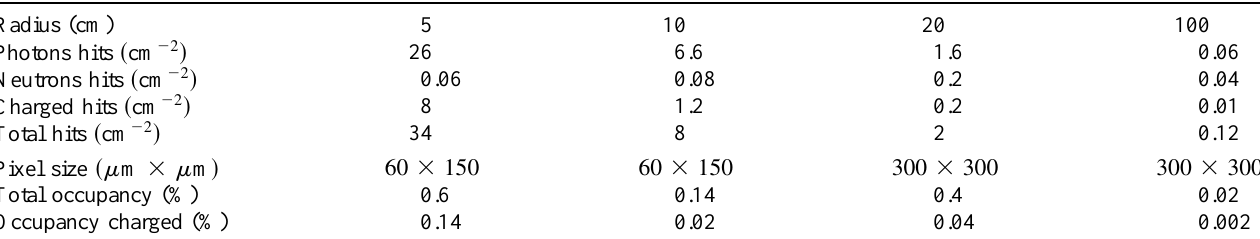
TABLE XV. Detector backgrounds from m decay.